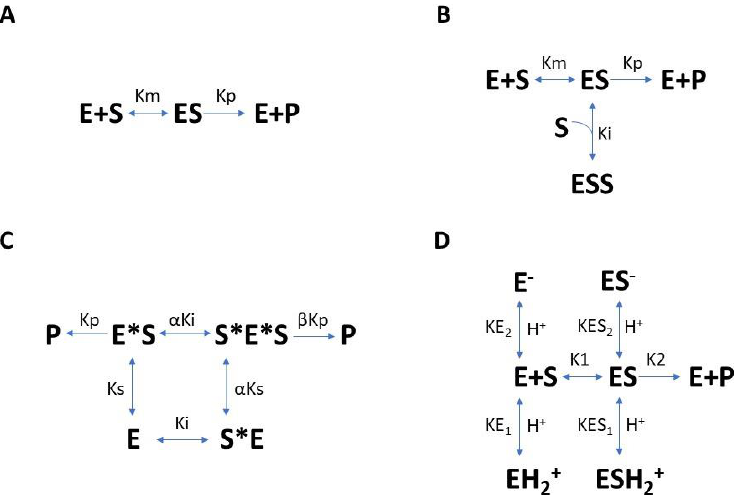
Figure 1. Mechanisms of enzymatic kinetics described using the models in this study: ( A ) Michaelis– Menten; ( B ) Michaelis–Menten with substrate inhibition; ( C ) two-binding site inhibition model. E · S indicates the complex with the substrate attached to the catalytic site; S · E denotes the substrate attached to the inhibitor site; ( D ) mechanism of pH effect on the enzyme with two dissociable groups where the individually protonated enzyme–substrate complex is catalytically active [29].